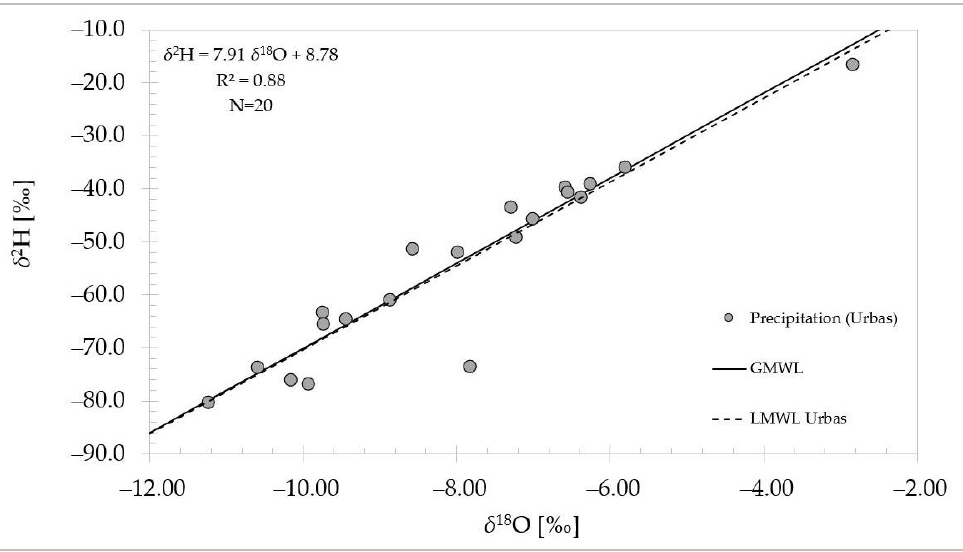
Figure 3. Estimated local meteoric water line.